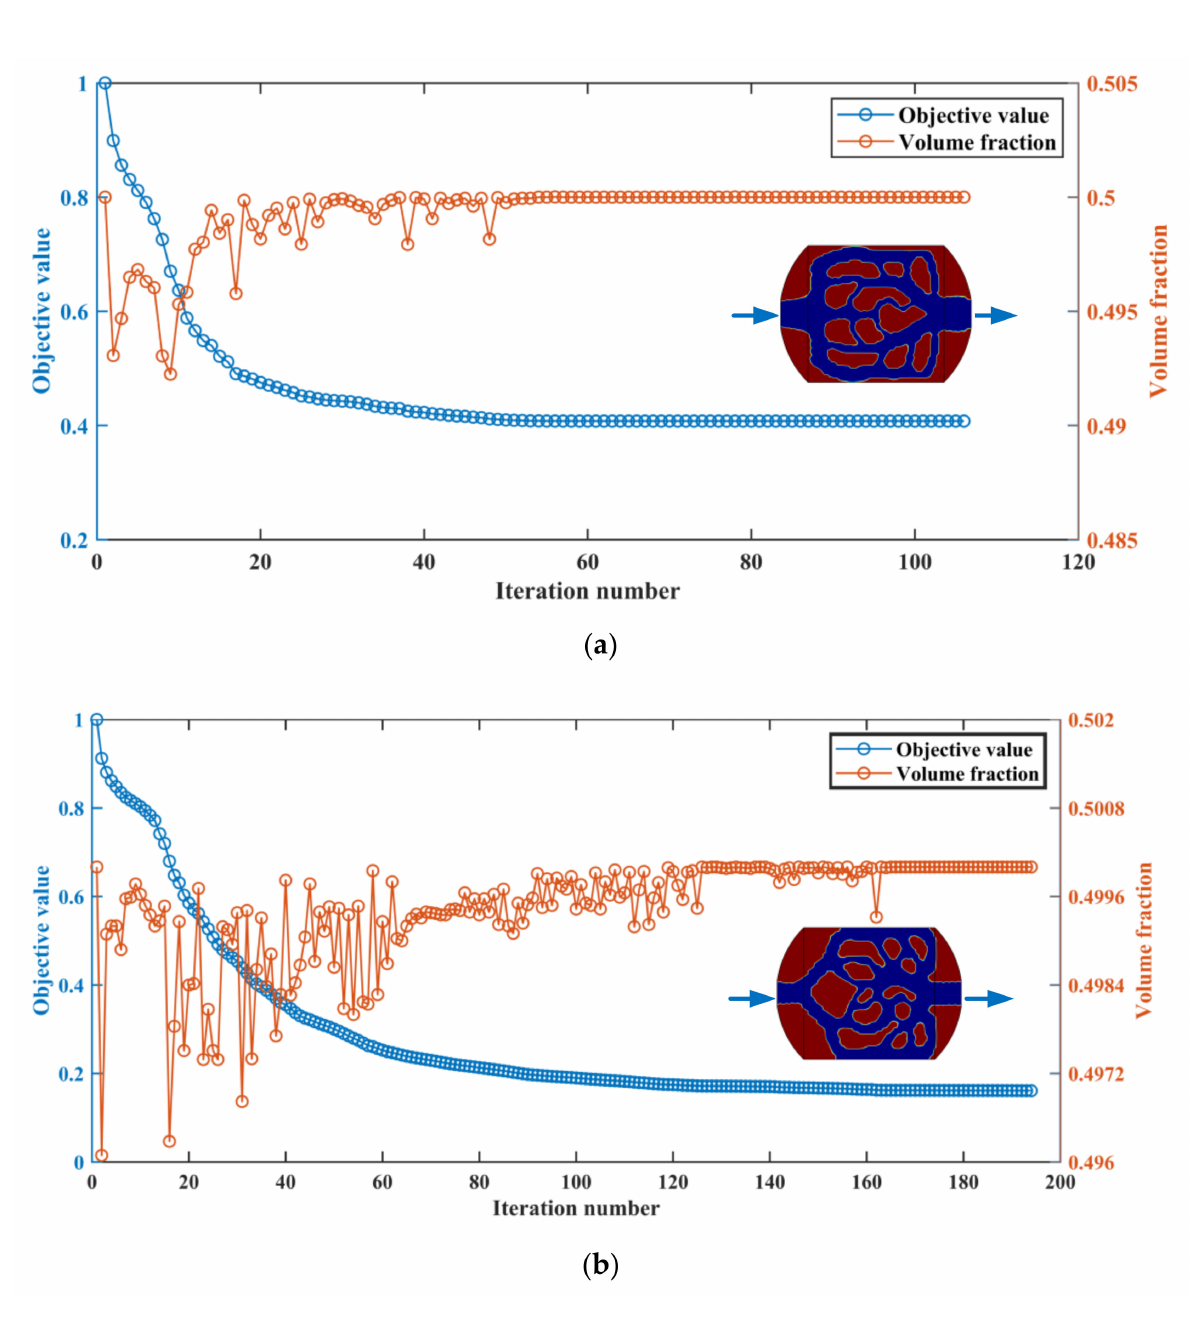
Figure 3. Iterative process of objective function value and volume fraction under two optimization schemes. ( a ) Minimum average temperature and fluid dissipated work; ( b ) Minimum temperature difference and fluid dissipated